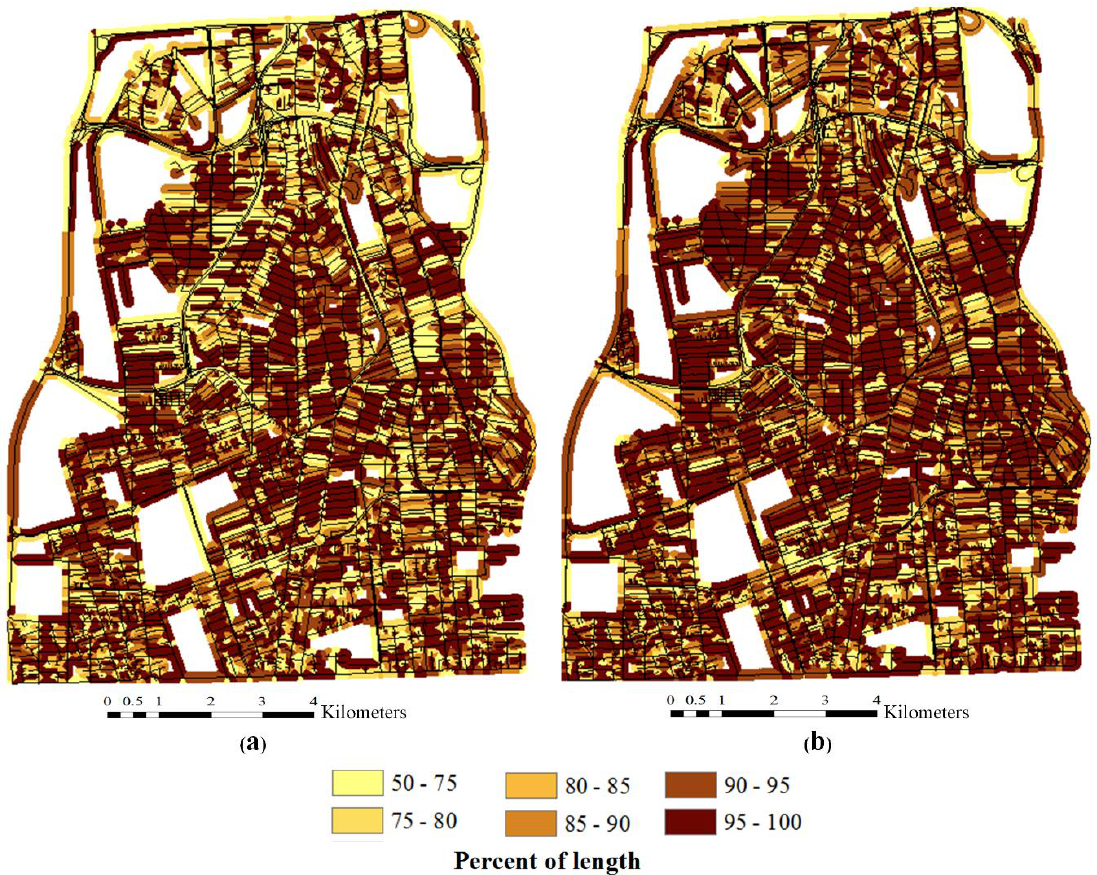
Figure 20. ( a ) Length percentage of the latest version of the OSM dataset; and ( b ) the length percentage of the enhanced dataset.